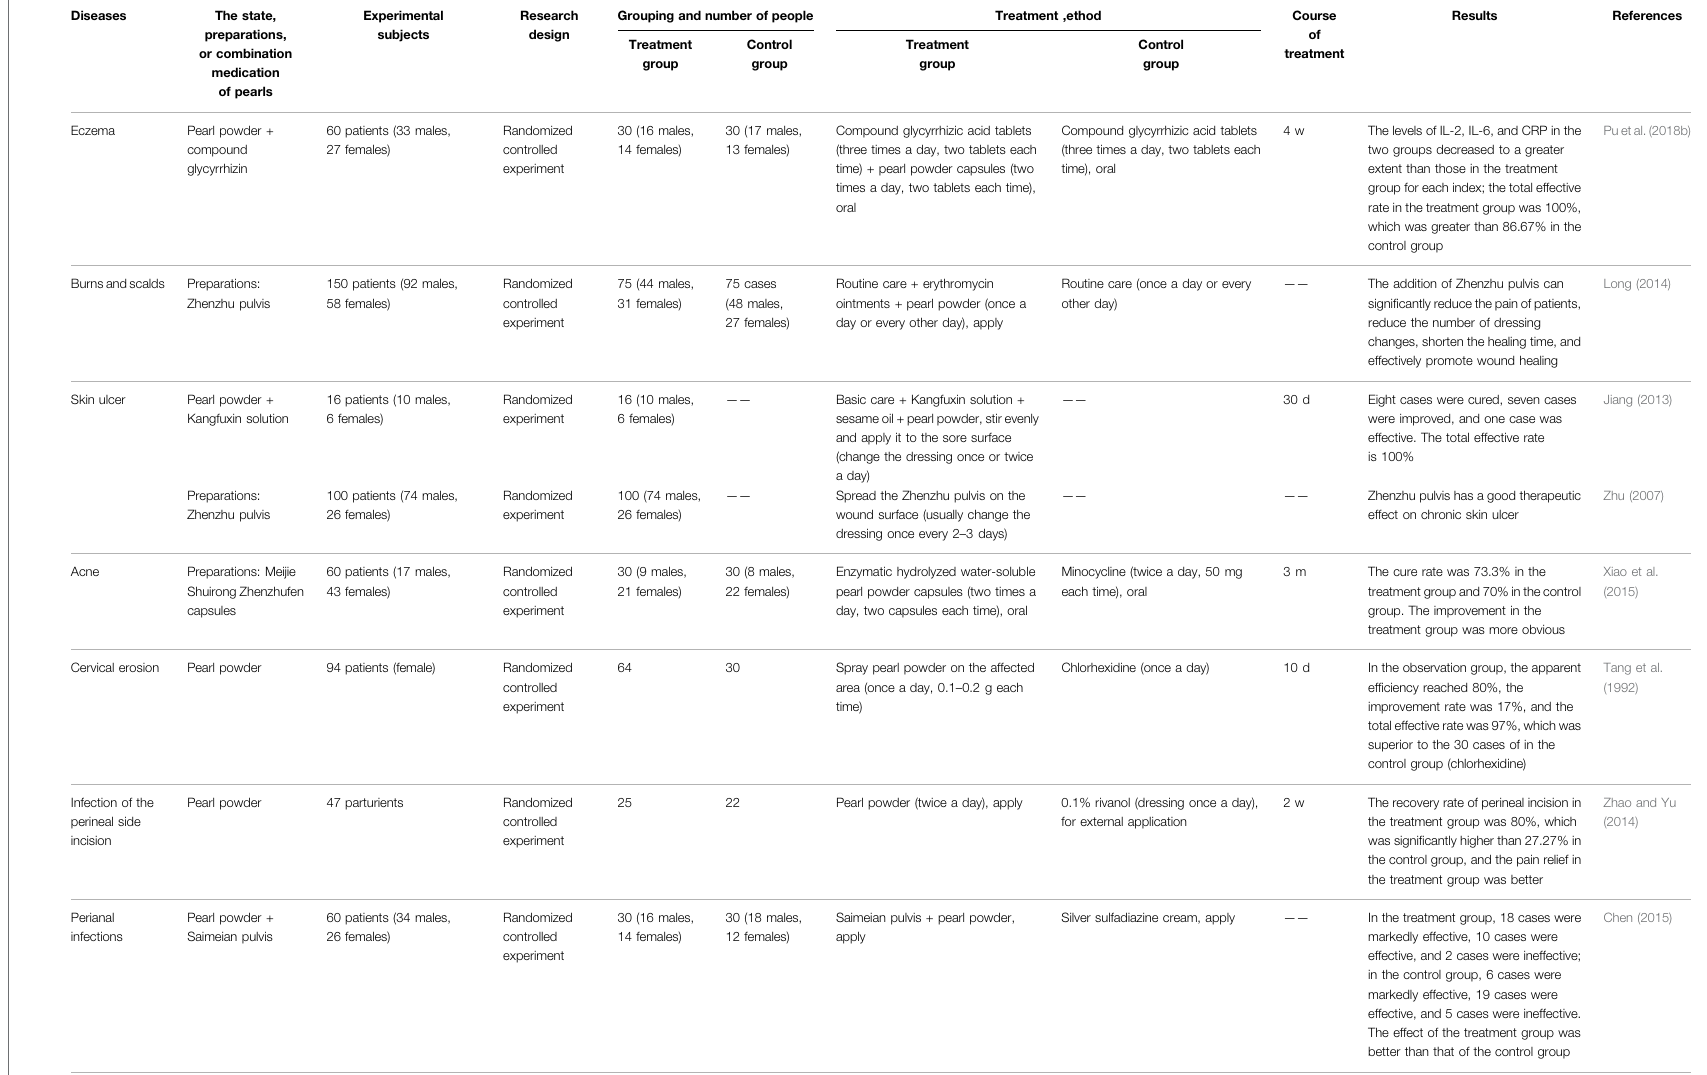
Note: in the table, “ d ” means days, “ w ” means weeks, and “ m ” means